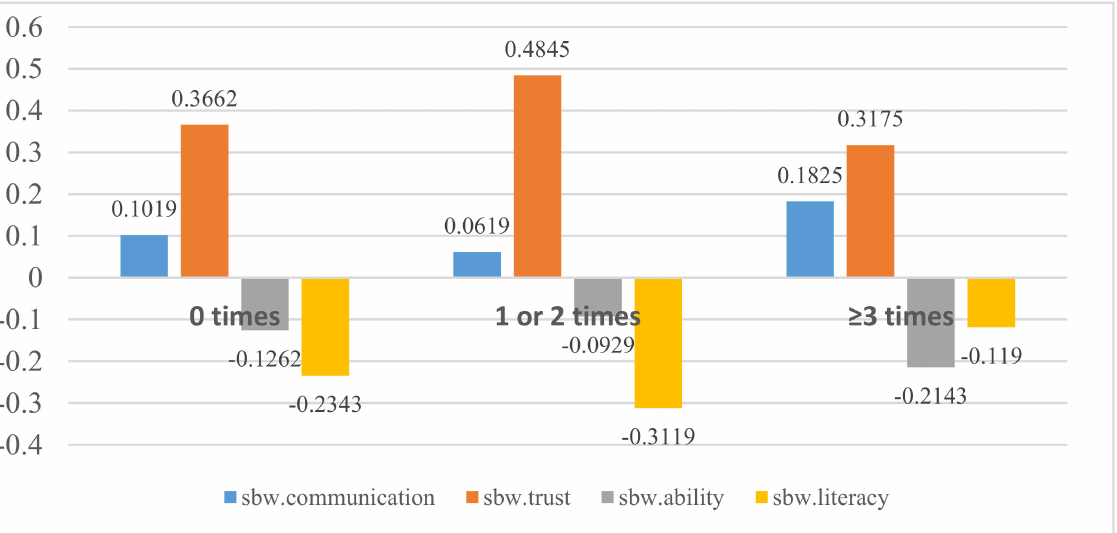
Figure A1. The best-worst scores for respondents with different numbers of hospitalizations in the last year on four statistically significant factors (SBW, standardized best-worst